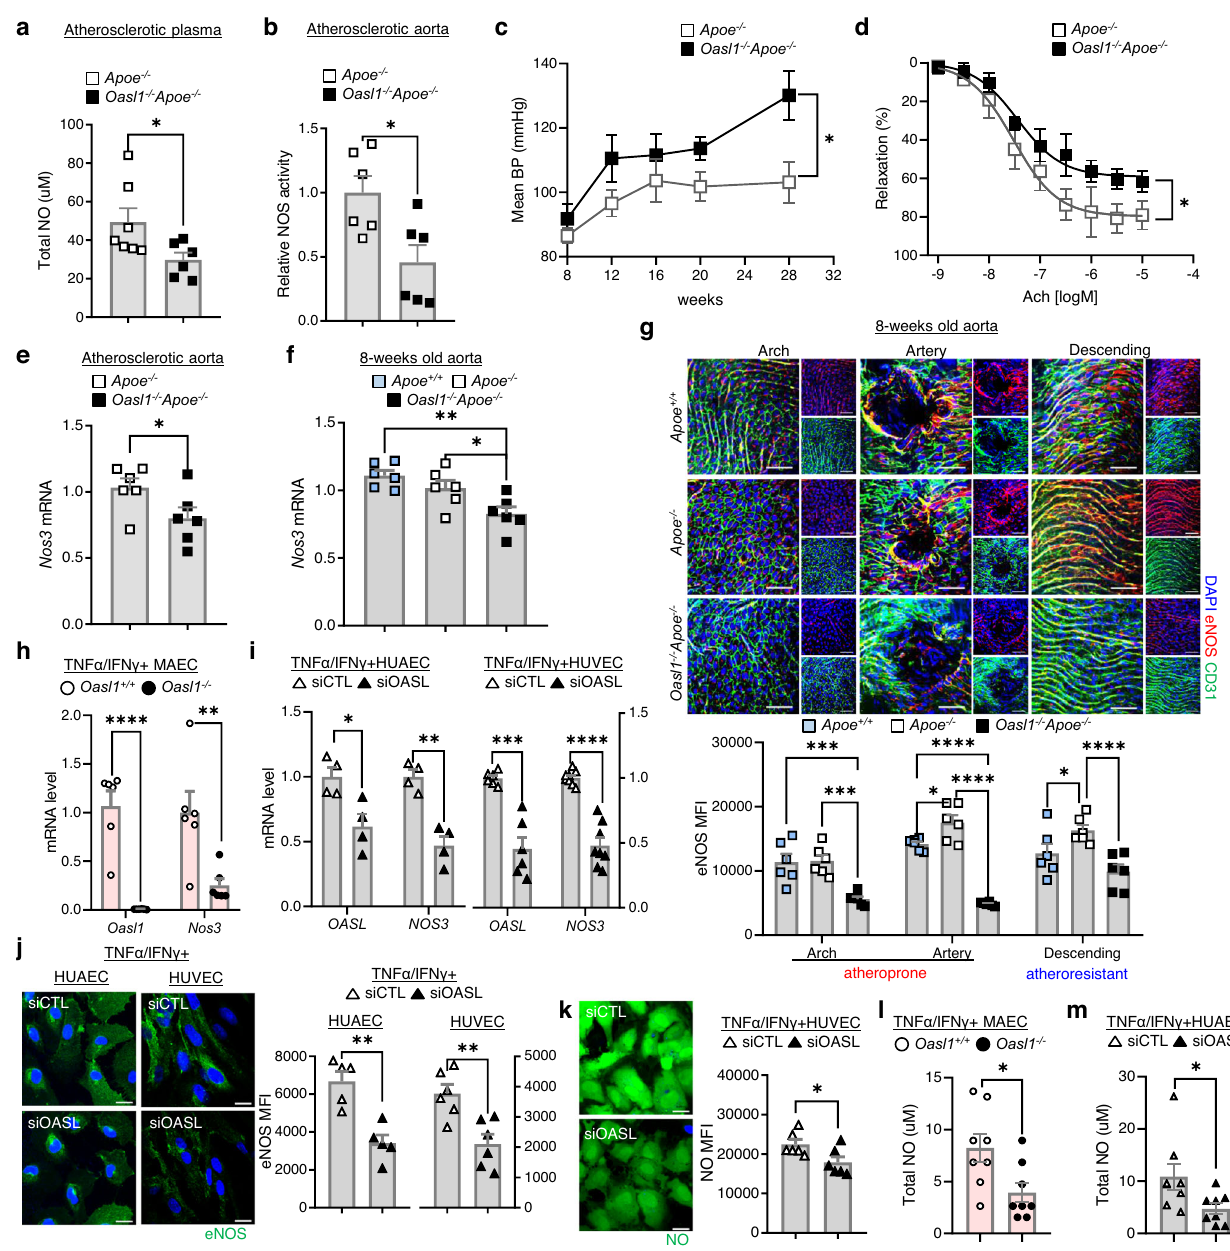
Fig. 5 | Oasl1 de fi ciency promotes endothelial dysfunction by reducing the levelsof Nos3 mRNA.a – e Apoe − / − and Oasl1 − / − Apoe − / − micewerefed anormalchow diet (NCD)for28weekstoallow atheroscleroticconditions todevelop.Totalnitric oxide(NO)levelsinplasma( p =0.0442,n=7for Apoe − / − ,n=6for Oasl1 − / − Apoe − / − )( a ) and NOS enzymatic activity in atherosclerotic aortas ( p =0.0156, n =6 per group) ( b ), as measured by the Griess method. c Mean blood pressure (BP) change mea- sured using tail-cuff techniques ( p =0.0063, n =7 per group). d The cumulative vascularrelaxation response of the aortic rings to acetylcholine (Ach) asmeasured by myography ( p =0.0350, n =4 per group). e Quantitative PCR analysis of Nos3 mRNA in aorta tissues ( p =0.0318, n =6 per group). f – g eNOS expression detected at multiple levels in the aortas of 8-week-old Apoe +/+ , Apoe − / − and Oasl1 − / − Apoe − / − mice. f Nos3 mRNA as measured by quantitative PCR ( p =0.0029; p =0.0413, n=6 pergroup). g Top: Enface IFstainingofeNOSproteininCD31 + ECs(arch: p =0.9877; p =0.0004; p =0.0002, branch: p =0.0472; p <0.0001; p <0.0001, descending: p =0.0306; p =0.1017; p <0.0001, n =6 per group). Bottom: Quantitation of the corresponding MFI results. Scale bar, 50 μ m. h Quantitative PCR analysis of Oasl1 and Nos3 mRNA levels in MAECs isolated from Oasl1 +/+ and Oasl1 − / − mice and sti- mulated withTNF α and IFN γ ( Oasl1 : p <0.0001, Nos3 : p =0.0087, n =6per group).